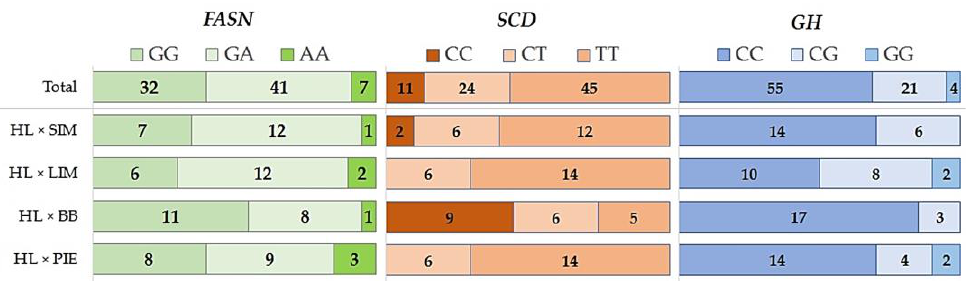
Figure 2. Number of observed FASN , SCD, and GH genotypes in sample. Table 1. Frequencies of allele variants of FASN , SCD, and GH genes observed and expected hetero- zygosity (Ho/He).